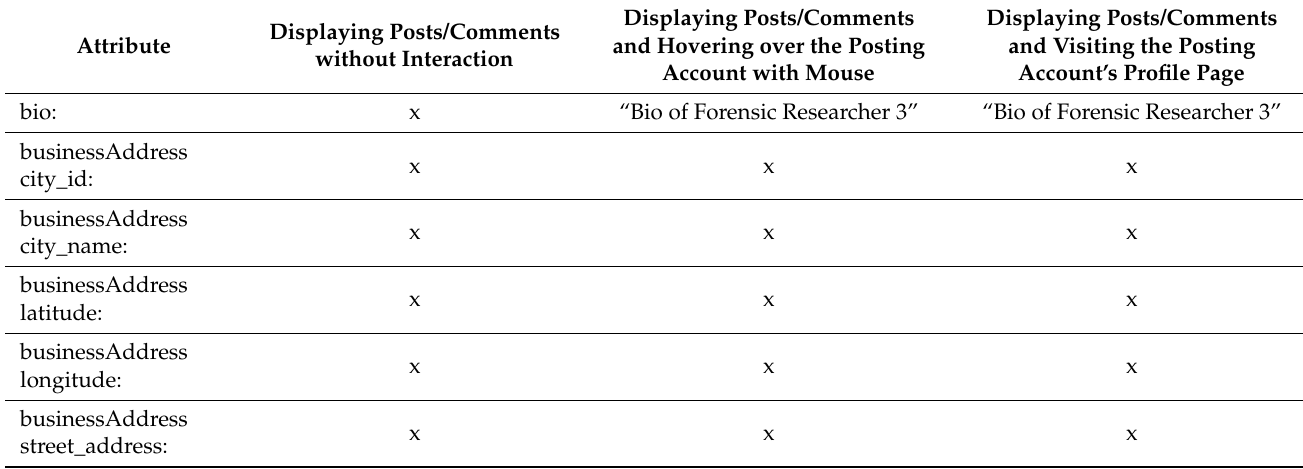
Table A1. Full List of Artifacts and Their Fields Found in users.users